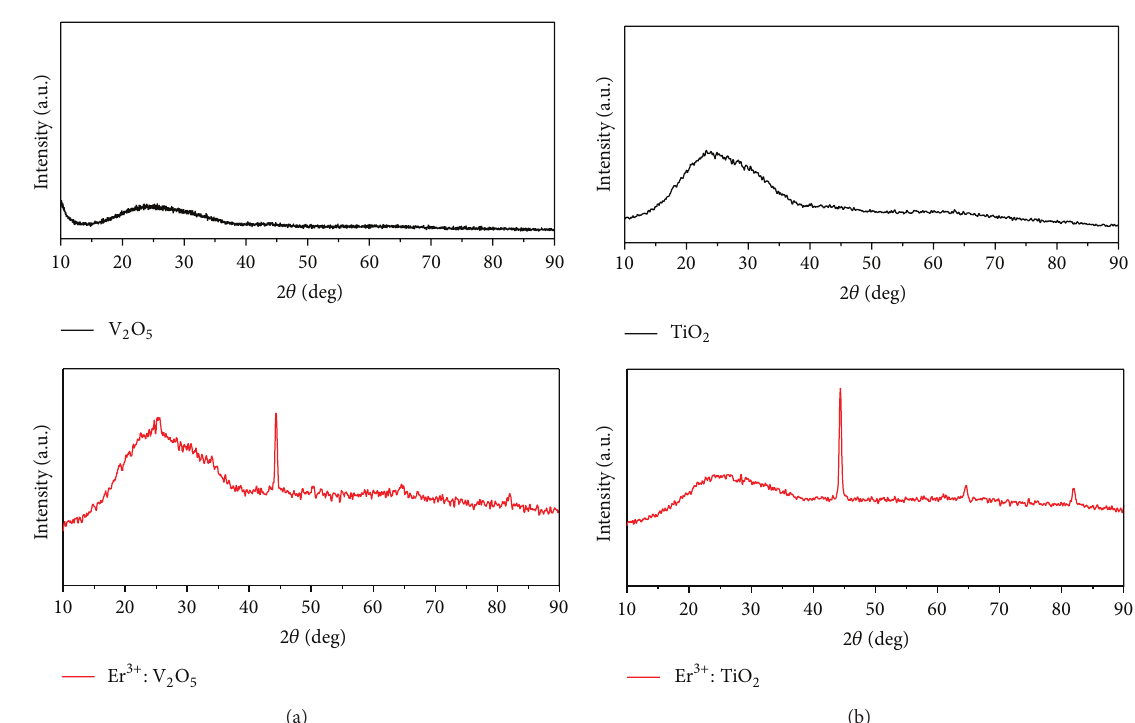
Figure 6: XRD spectra of erbium-undoped/erbium-doped (a) V 2 O 5 , (b) TiO 2